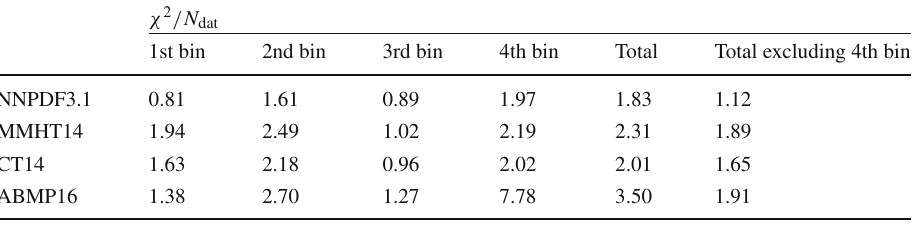
Table 2 Same as in Table 1 but with only NLO QCD theory and without LL electroweak